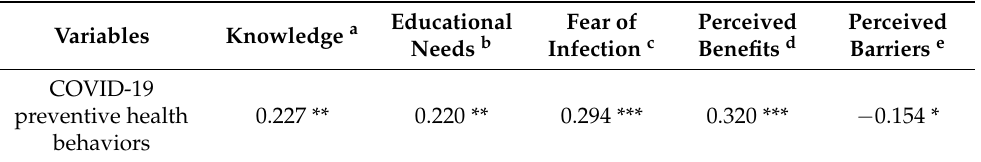
Table 3. Correlations among COVID-19 knowledge, educational needs, fear of infection, perceived benefits and barriers, and preventive health behaviors. Educational Fear of Perceived Perceived Variables Knowledge a Needs b Infection c Benefits d Barriers e COVID-19 preventive health 0.227 ** 0.220 ** 0.294 *** 0.320 *** − 0.154 * behaviors